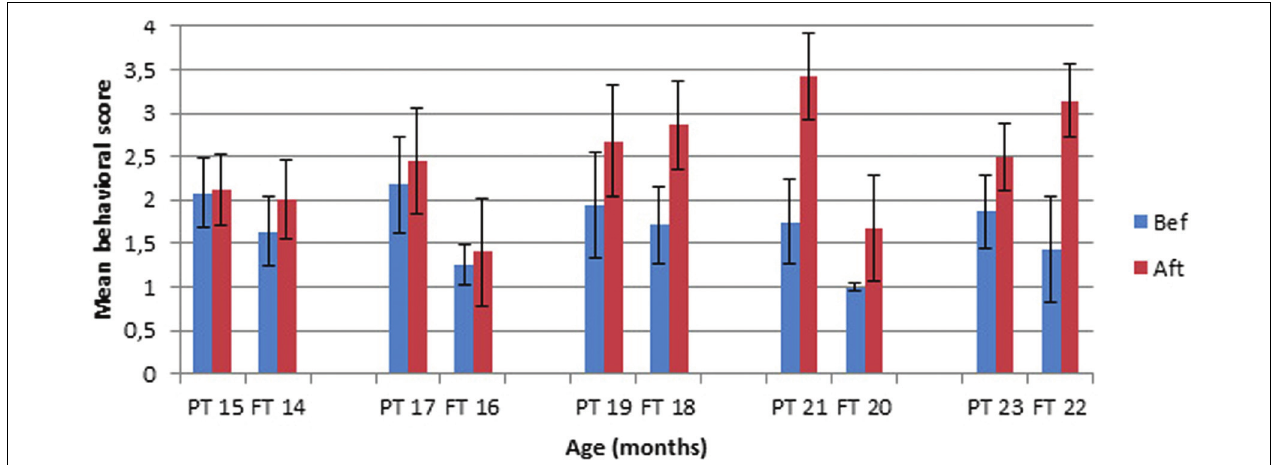
FIGURE 4 | Mean behavioral score at C4–C5 Before versus After demonstration in Preterm (PT) and Full-term (FT) infants.